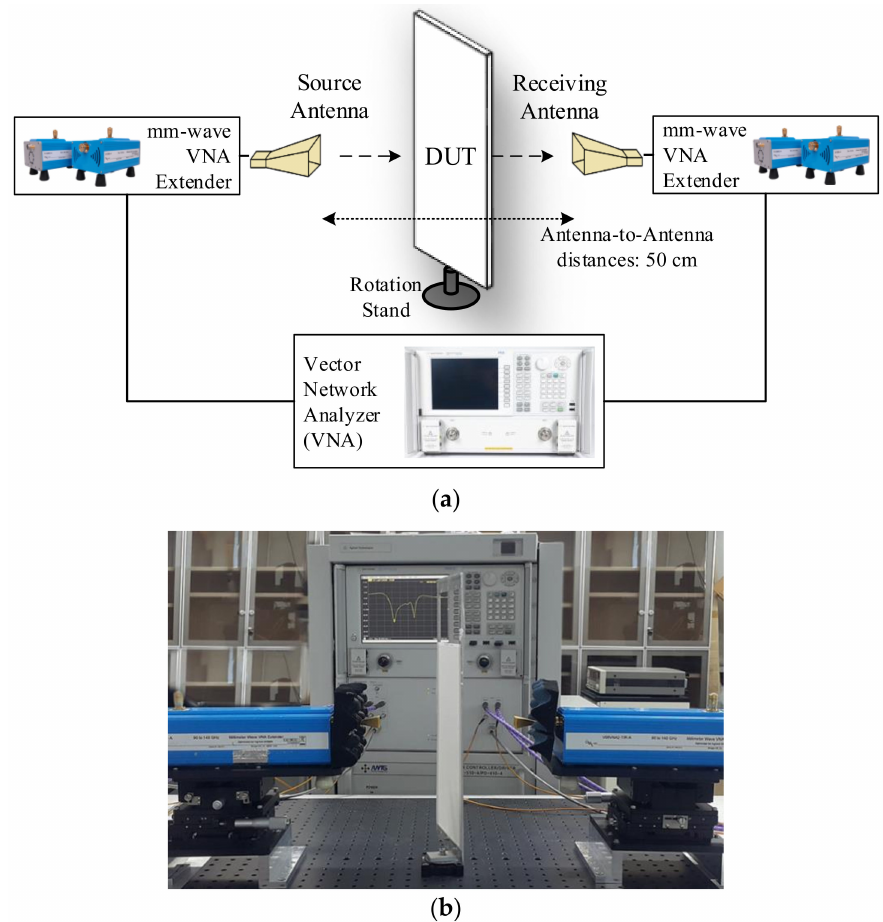
Figure 9. Measurement setup: ( a ) Block diagram, ( b ) DUT with oblique angle incidence of 14 ◦ .